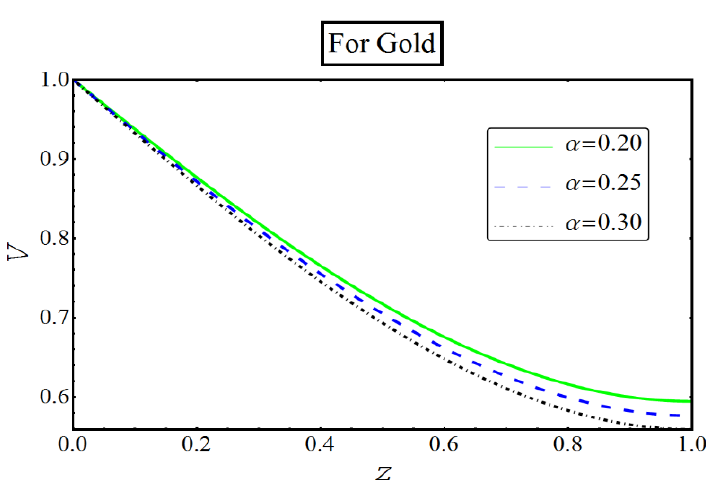
Figure 16. Behavior of azimuthal velocity for the thermocapillary parameter with gold particles.